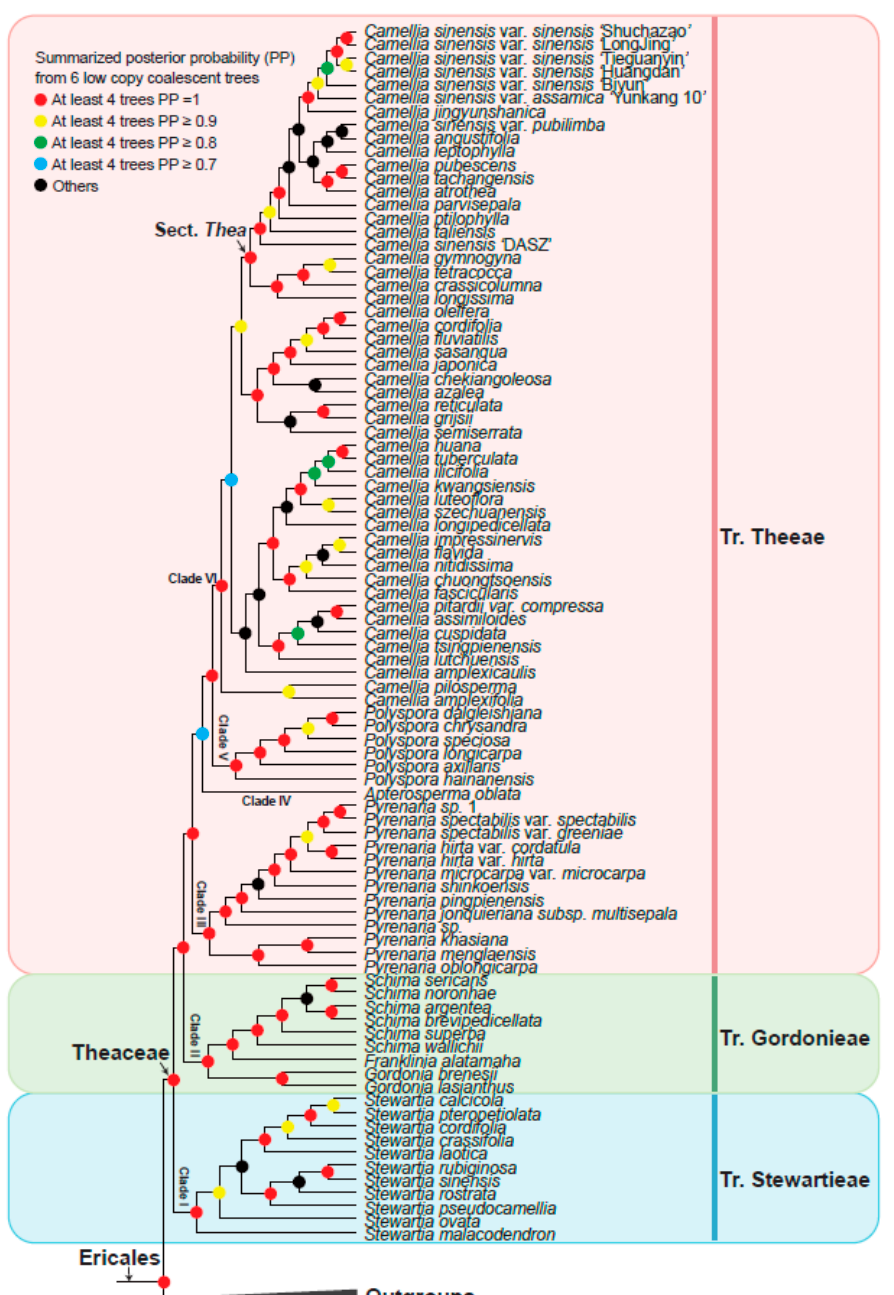
Figure 3. Summarized Theaceae phylogenetic relationships from six low-copy coalescent trees by ASTRAL. Colored labels at the nodes represent the summarized status of posterior probability (PP) in our six low copy coalescent trees: red circles for PP = 1 in at least four trees; yellow, green, and blue circles for ≥ 0.9 PP, ≥ 0.8 PP, and ≥ 0.7 PP in at least four trees, respectively; and black circles for other types. The pink, green, and blue vertical line on the right indicates Tr. Theeae, Tr. Gordonieae, and Tr. Stewartieae, respectively. The outgroups collapsed into a black triangle.